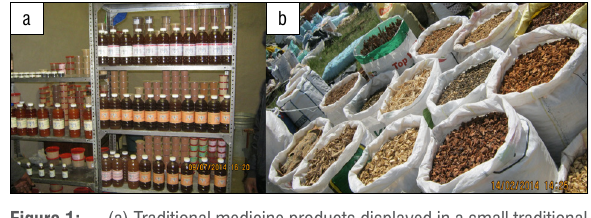
Figure 1: (a) Traditional medicine products displayed in a small traditional medicine chemist and (b) dried plant raw materials displayed by hawkers in an informal street